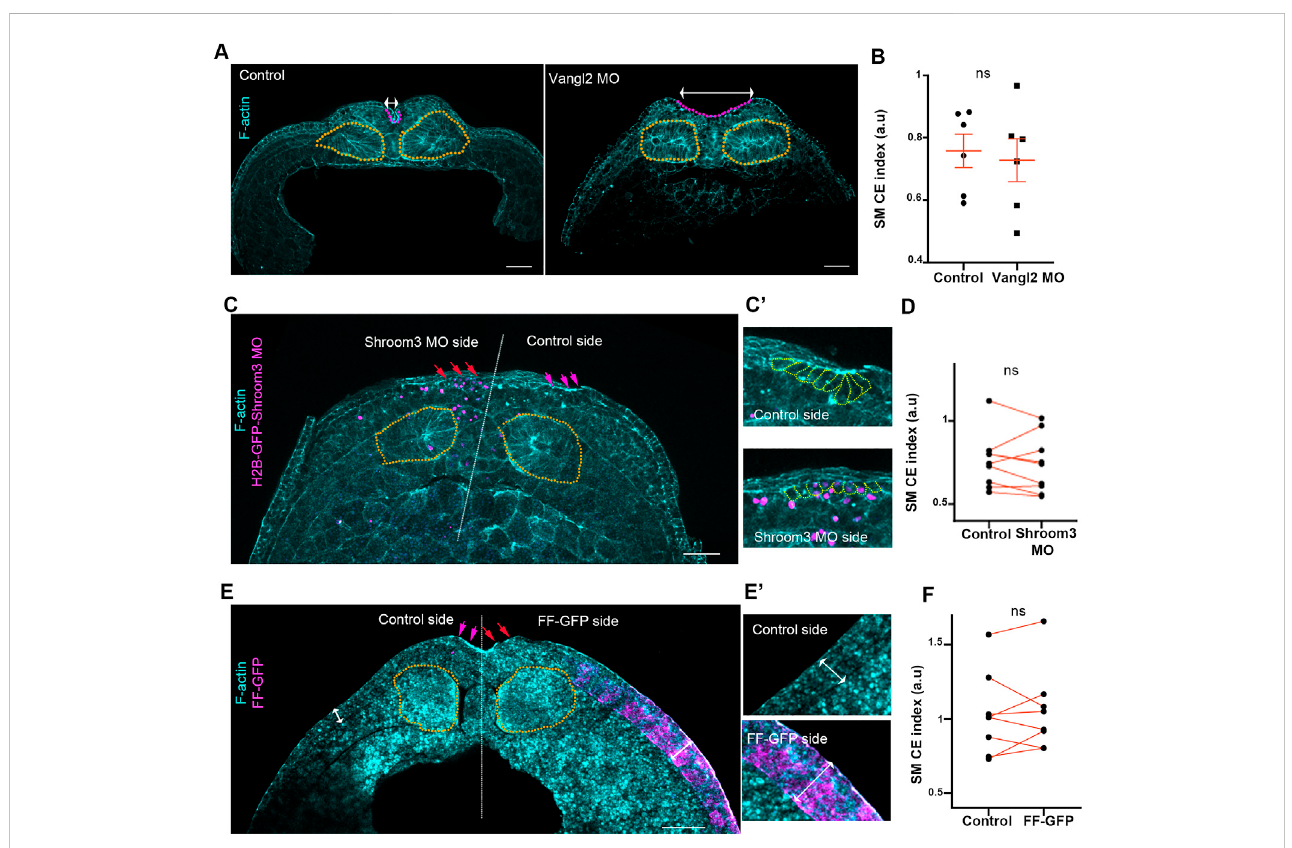
FIGURE 2 Somitic mesoderm convergent extension occurs independently from neural plate morphogenetic program and surface ectoderm development. (A) Representative imagesoftransversecrosssectionsfromcontrolandVangl2 neuralplatemorphantstage16embryos. ControlandVangl2morphantembryos are siblings raised side by side. Orange outline: Somitic mesoderm. Purple Outine: neural plate. Double headed arrows: neural plate width. Scale bar: 100 μ m (B) Quanti fi cation of somitic mesoderm convergent extension in control and Vangl2 neural plate morphant embryos. Two-sided unpaired Student ’ s t -test; ns, p = .591;mean ± SEM; n = 6 embryos. (C) Representative images of transverse cross sections from Shroom3 unilateral morphant neural plate stage 16 embryo. Orange outline: Somitic mesoderm. Purple arrows: neural plate hinge point at the control neural plate side. Red arrows: absence of neural plate hinge point at the Shroom3 morphant side. Scale bar: 100 μ m (C ’ ) Magni fi ed image from neural plate control and Shroom3 morphant side. Orange outlines: neural plate cells. Cells at the control side acquire a wedge shape, characteristic of apical constriction. Cells at the Shroom3 morphant side fail to undergo apical constriction and remain cuboidal. (D) Quanti fi cation of somitic mesoderm convergent extension in control and Shoom3 morphant neural plate. Two- sided paired Student ’ s t -test; ns, p = .516 n = 9 embryos (E) Representative images of transverse cross sections from a stage 16 embryo expressing FF-GFP at theonesideofthesurfaceectoderm.Orangeoutline:Somiticmesoderm.Purple arrows:neuralplatehingepointatthecontrolneuralplateside.Redarrows: absence of neural plate hinge point at the FF-GFP surface ectoderm side. Scale bar: 100 μ m (E ’ ) Zoomed images of control and FF-GFP surface ectoderm. Double arrowheads: surface ectoderm thickness. Control surface ectoderm is a double layered tissue while the FF-GFP surface ectoderm is composed